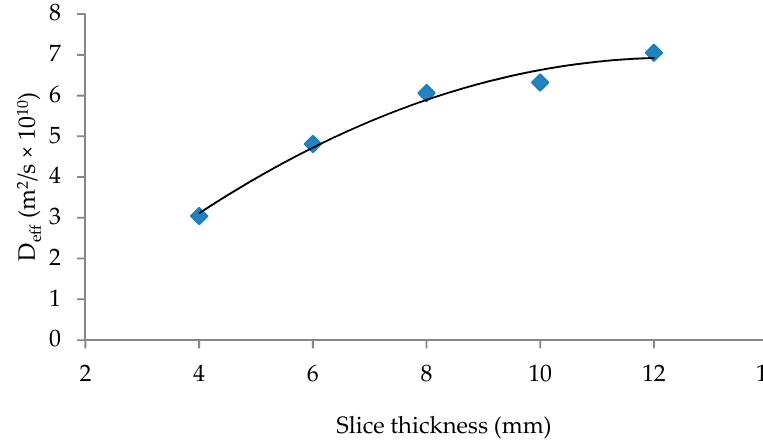
Figure 9. E ff ective di ff usion coe ffi cient vs. slice thickness. Figure 9. Effective diffusion coefficient vs. slice thickness.